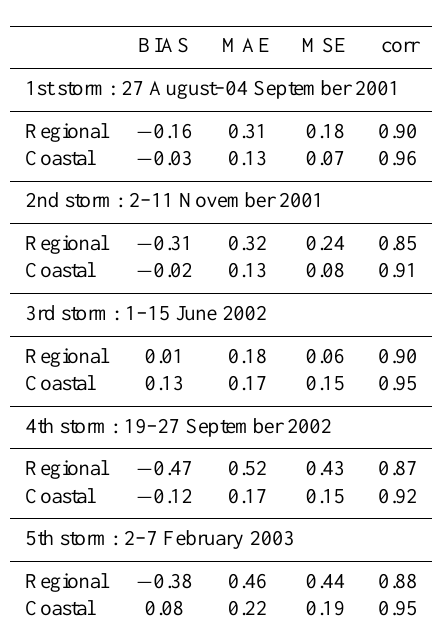
p at Civitavecchia.